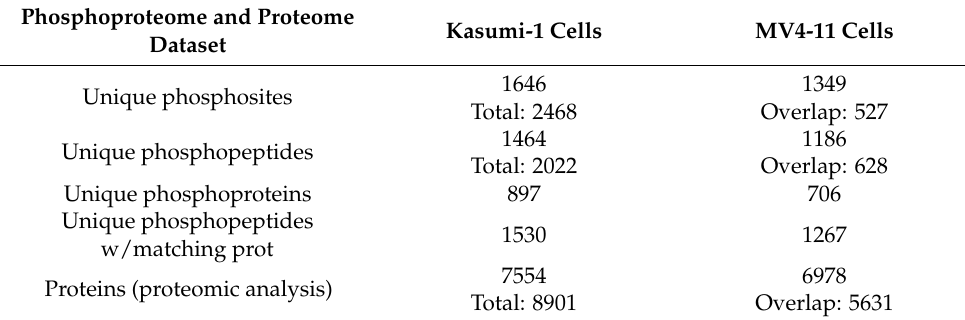
Figure 4. Phosphoproteomic and proteomic analysis of paediatric AML cells treated with apoptotic combination treatments: ( A ) Workflow for the investigation of phosphorylation changes induced in Kasumi ‐ 1 and MV4 ‐ 11 cells after treatment with combination treatments of ABT ‐ 737 + Purvalanol ‐ A or ABT ‐ 737 + AKTi ‐ 1/2 + SU9516. Three biological replicates of each group were evaluated. ( B ) Quantitative phosphoproteomic profiling of Kasumi ‐ 1 and MV4 ‐ 11 cell identified proteins ( top ) and phosphoproteins ( bottom ) that were significantly modulated. Colour scale indicates fold ‐ change (treated vs. control) threshold of 1.5 (FC ≥ 1.5) to define the down ‐ and upregulated phosphopeptides and proteins. Table 1. Number of identified and significantly modulated phosphopeptides and proteins in Kasumi ‐ 1 and MV4 ‐ 11 cell lines.